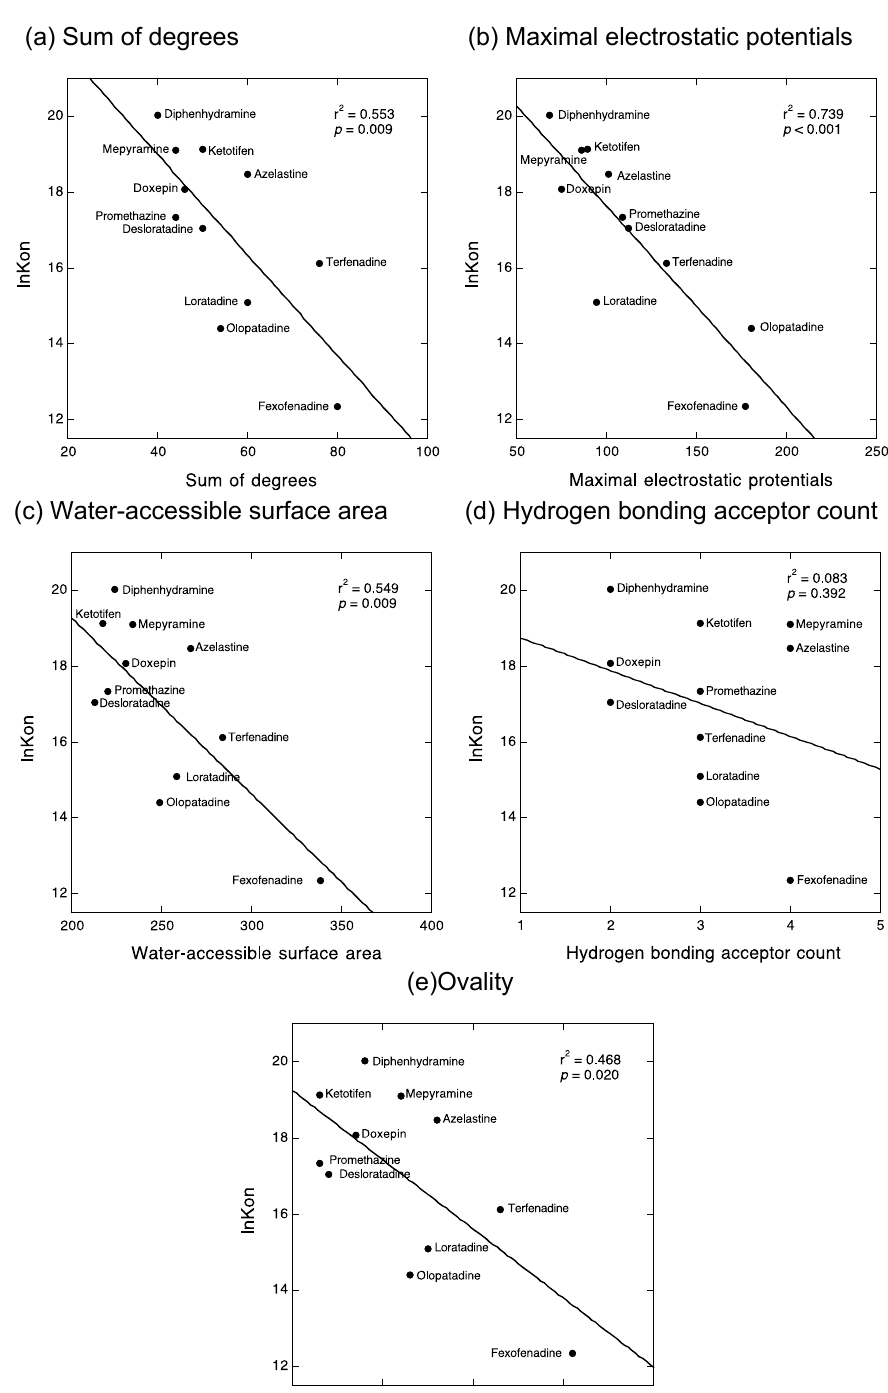
Figure 3. Relationship between the k on values of antihistamines and their physicochemical properties involved in thermodynamic binding parameters. Relationship of the values of ln k on with sum of degree ( a ), maximal electrostatic potentials ( b ), water-accessible surface area ( c ), hydrogen bonding acceptor count ( d ), and ovality ( e ). A significant relationship was observed for all parameters except between the values of ln k on and the hydrogen bonding acceptor count ( d ). k on : rate constant of association.